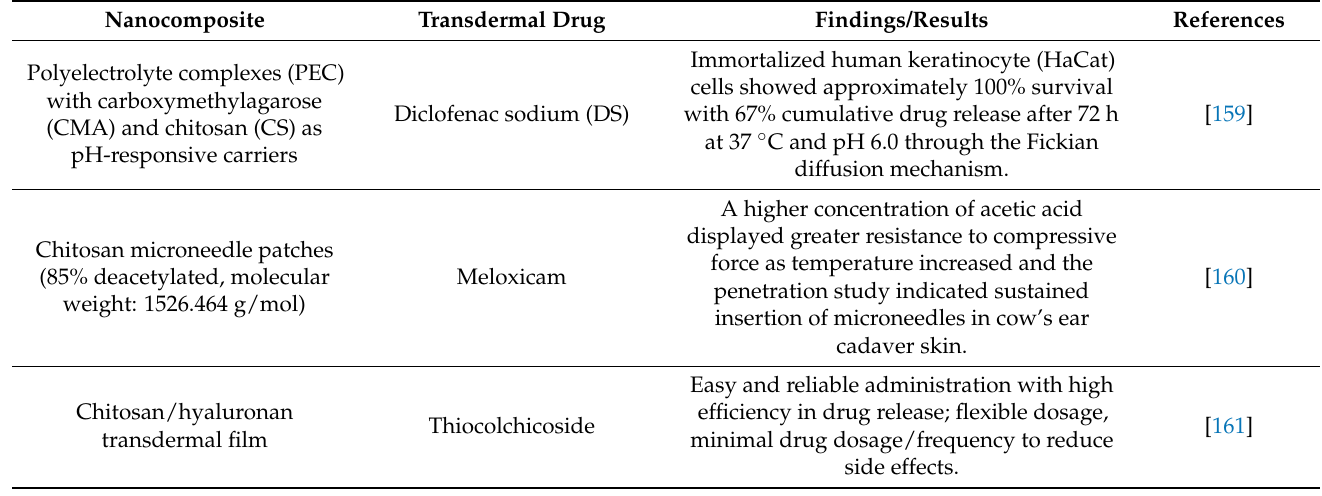
Table 3. The development of various nanoconjugates from chitosan in the past